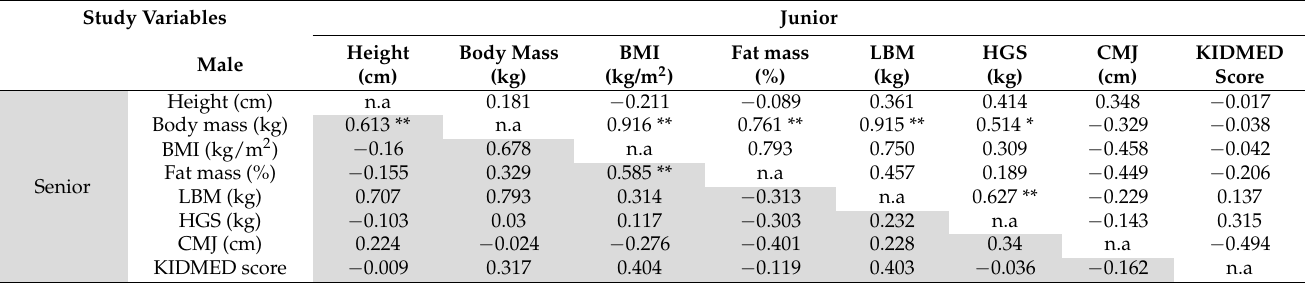
Table 6. Male beach handball players’ correlation between body composition, performance and MD adherence variables. Study